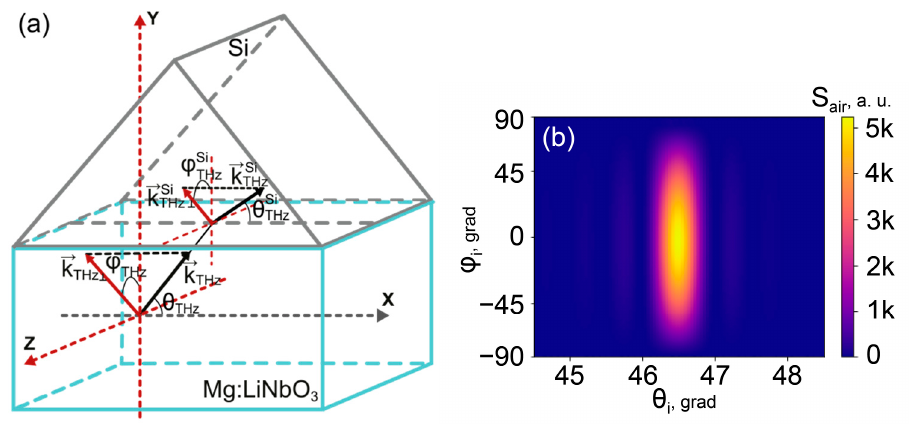
Figure 2. ( a ) Directions of the THz wave components in the crystal and inside the Si coupler; ( b ) angular distribution of the power density at 1 THz inside the Si coupler. ( b ) angular distribution of the power density at 1 THz inside the Si